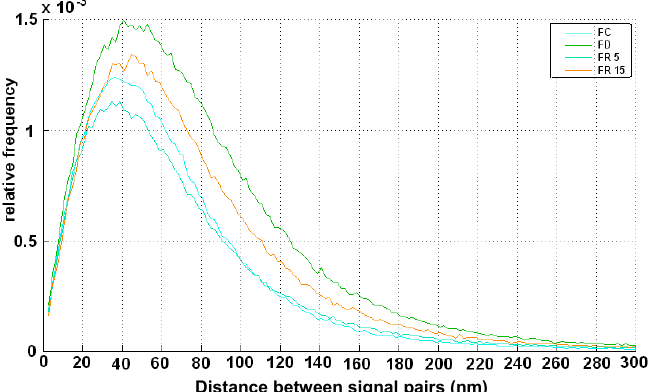
Figure 4. Relative frequency of signal-pair distances (normalized over all distances) in γ -H2AX clusters for four different preparation conditions.